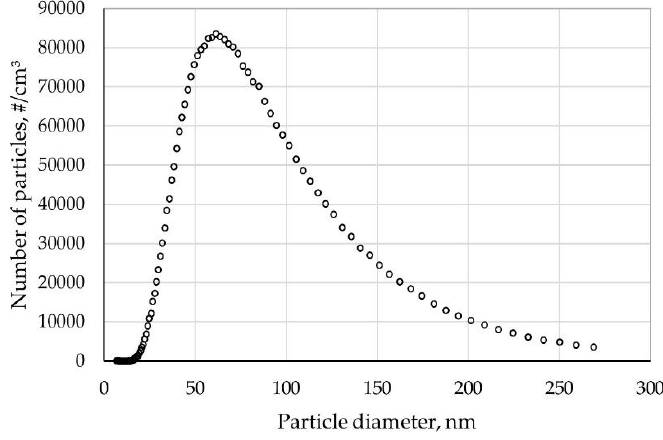
Figure 6. NaCl particle size distribution.